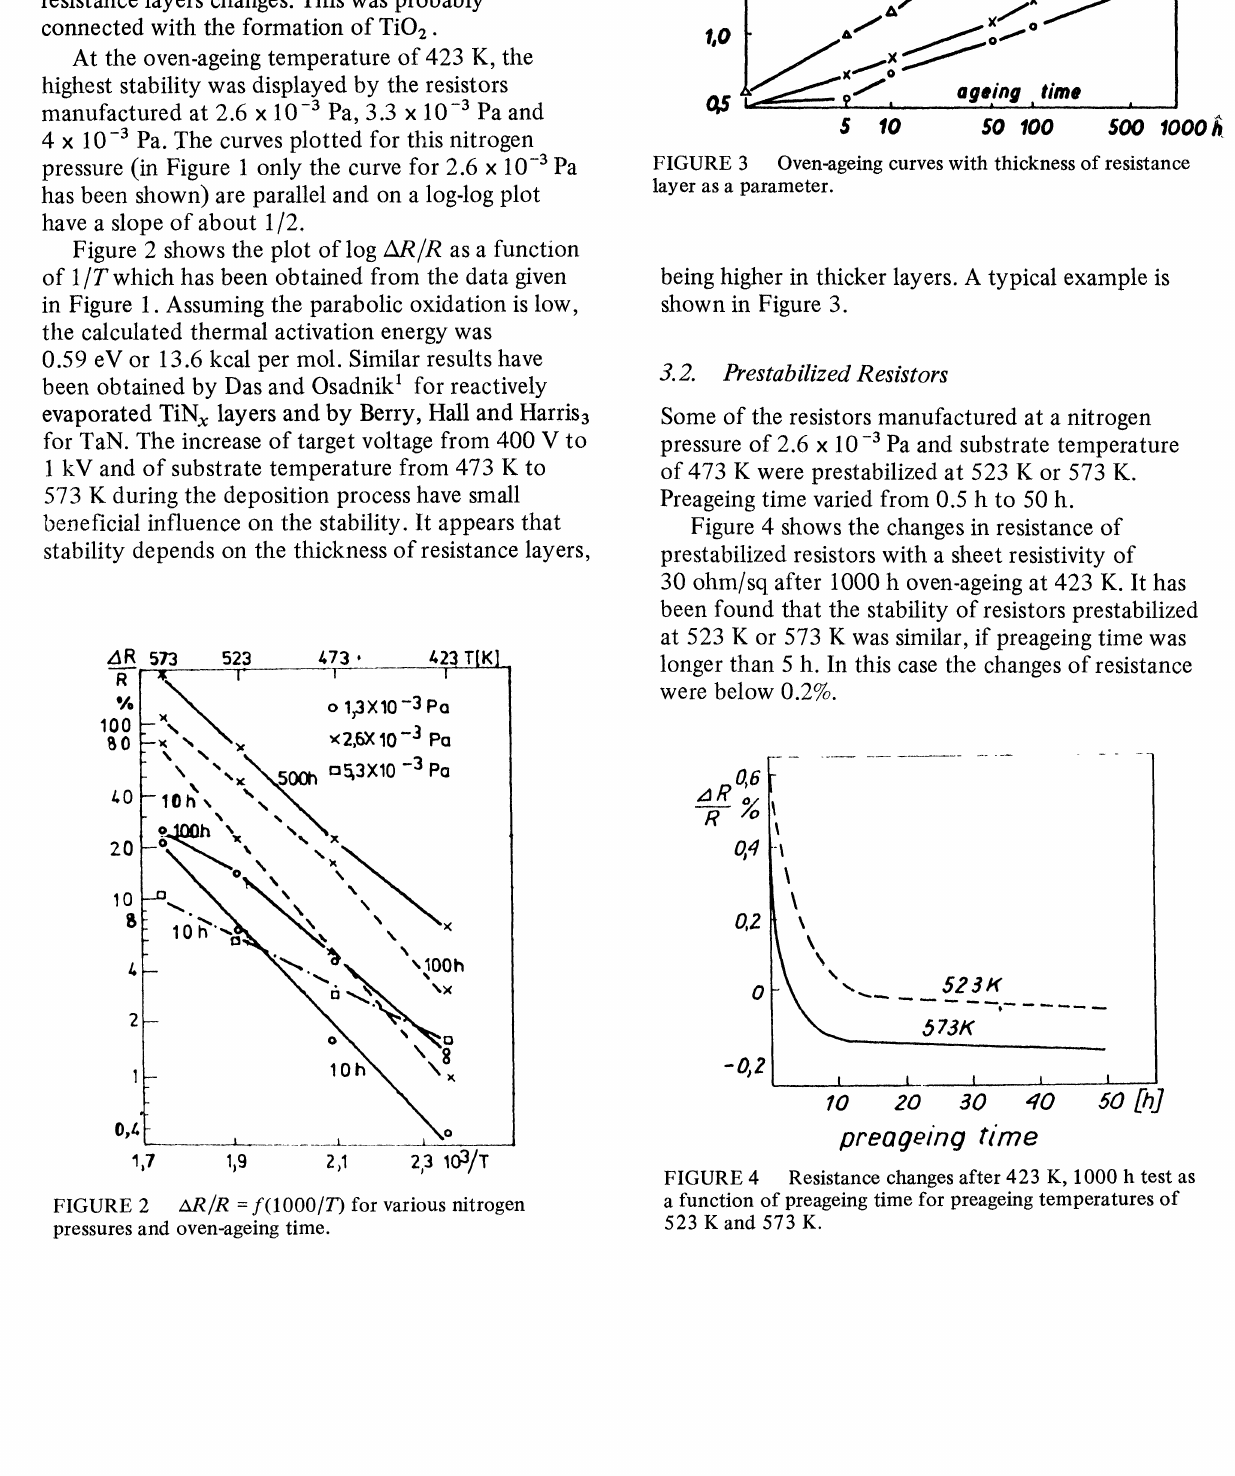
FIGURE 3 Oven-ageing curves with thickness of resistance layer as a parameter.